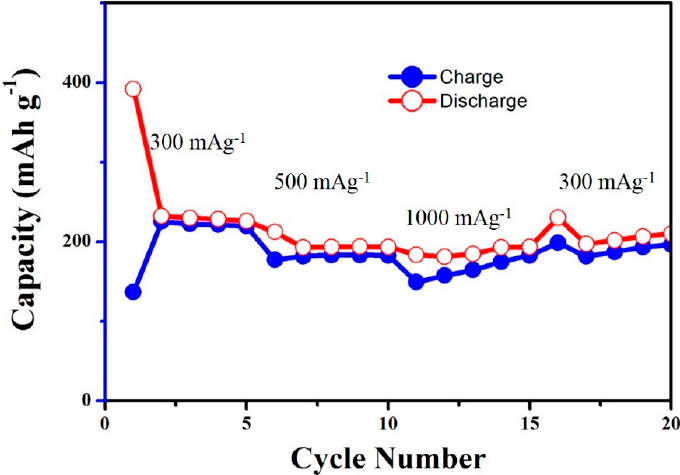
Figure 5. The rate performance at di ff erent current densities of CNC–SnO 2 NF800 composite electrodes between 0.01 and 2 V. The rate performance experiment was carried out by using the lithium-ion battery (LIB)’s cell after 500 cycles at a current density of 100 mA g − 1 .